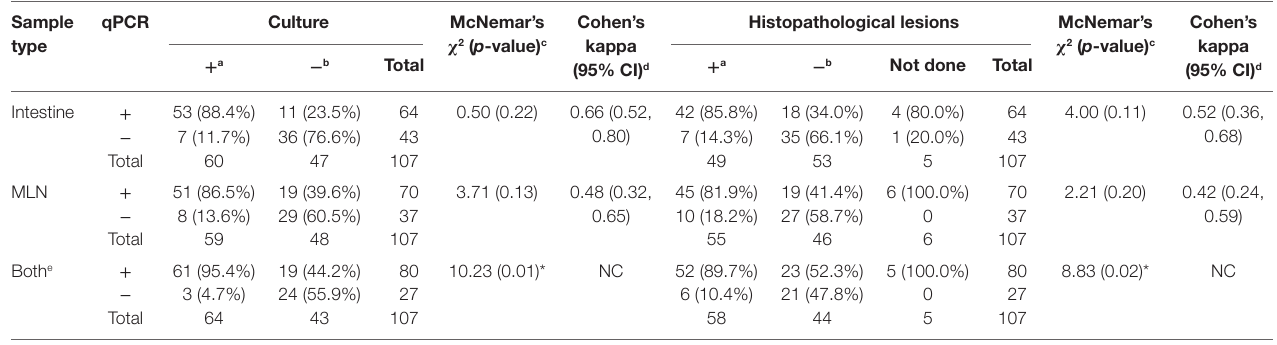
TaBle 1 | Comparison of qPCR test results of tissues (intestine and MLN) with reference test (culture and histopathological lesion score)